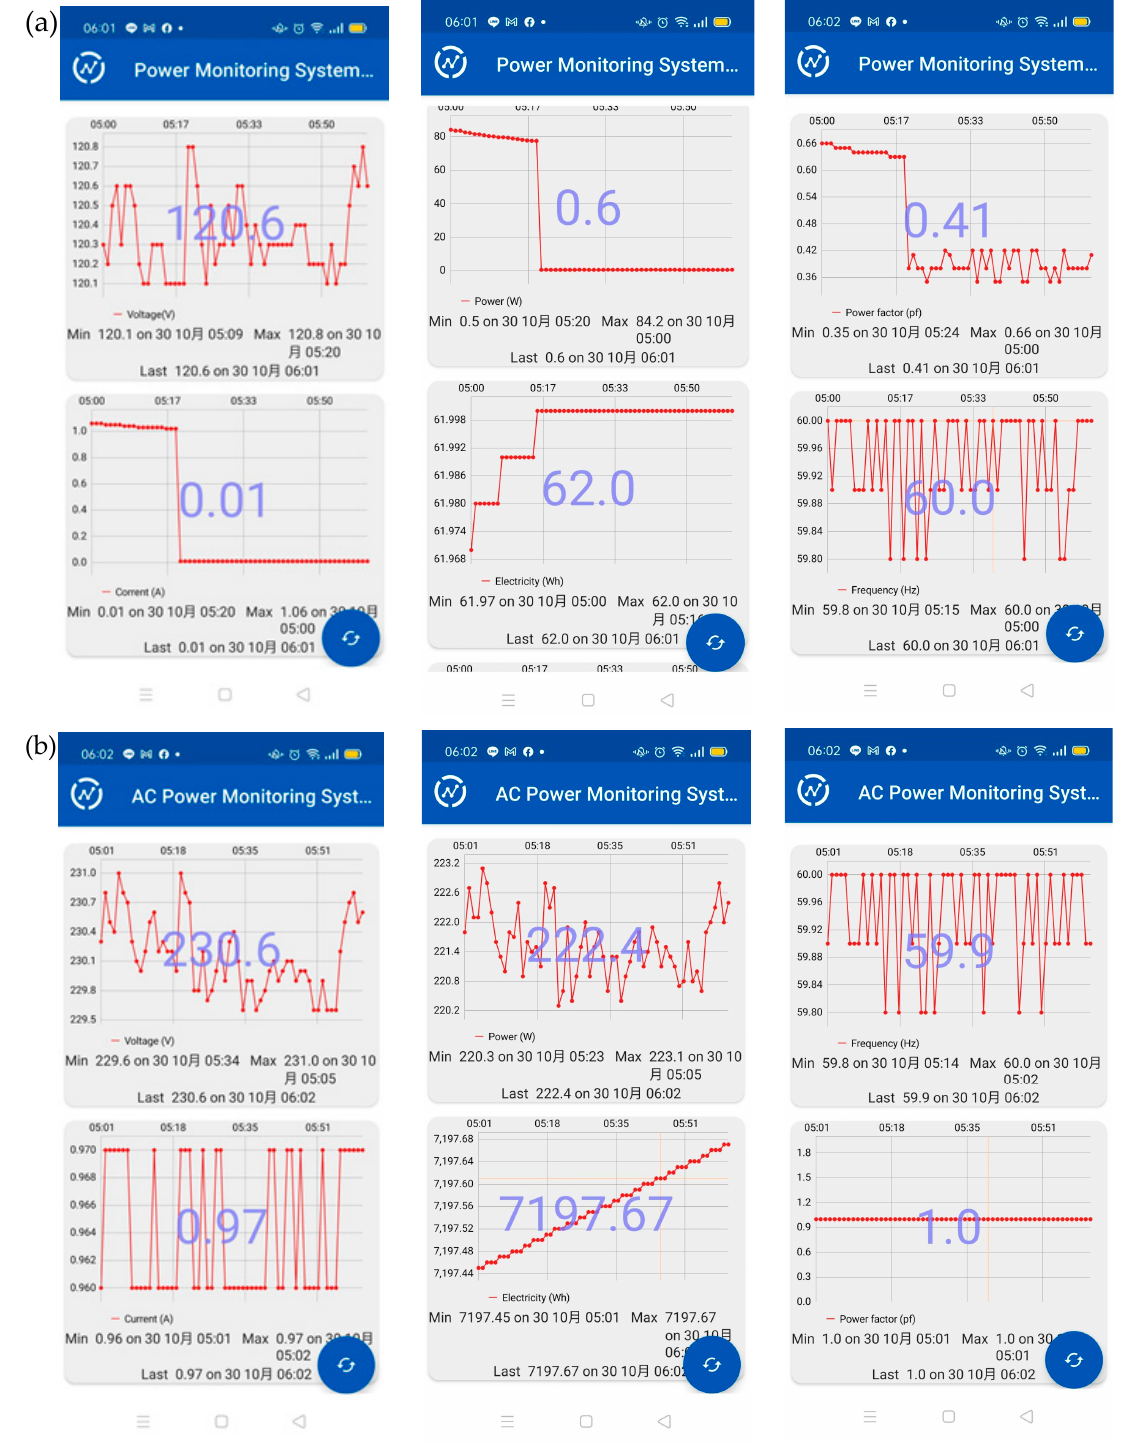
Figure 10. Parameter visualization of voltage, current, electrical power and energy, pf, and frequency in the ThingView: ( a ) Refrigerator; ( b ) Air conditioner.